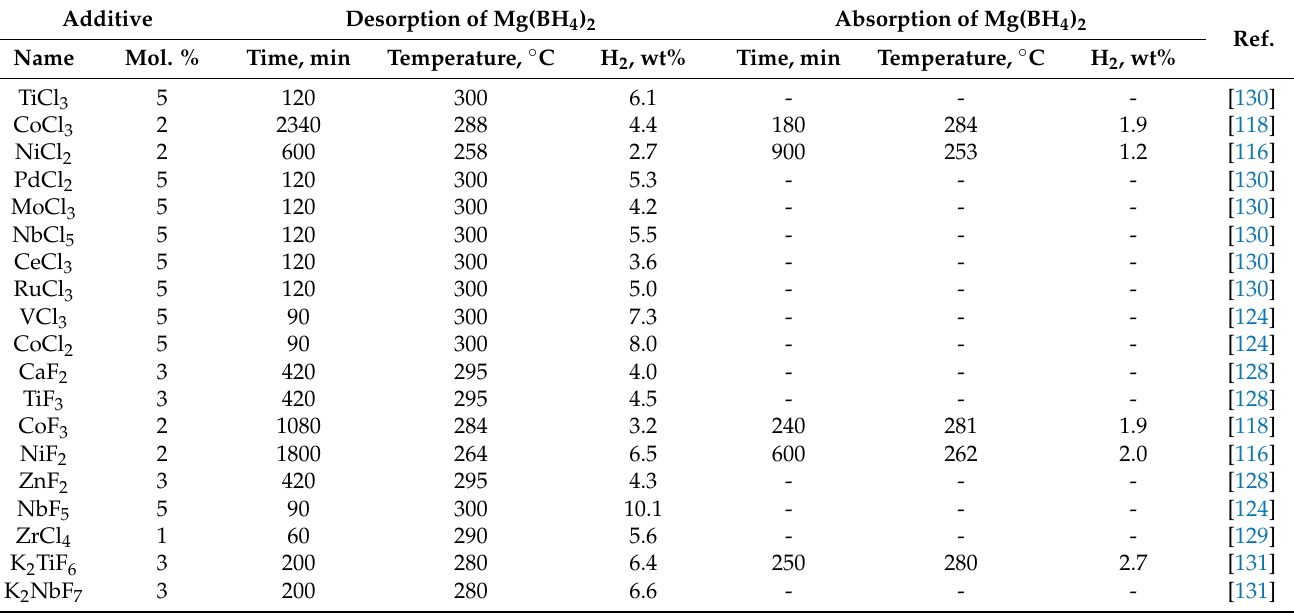
Table 6. Influence of several metal halides additives on the hydrogen storage properties of Mg(BH 4 ) 2